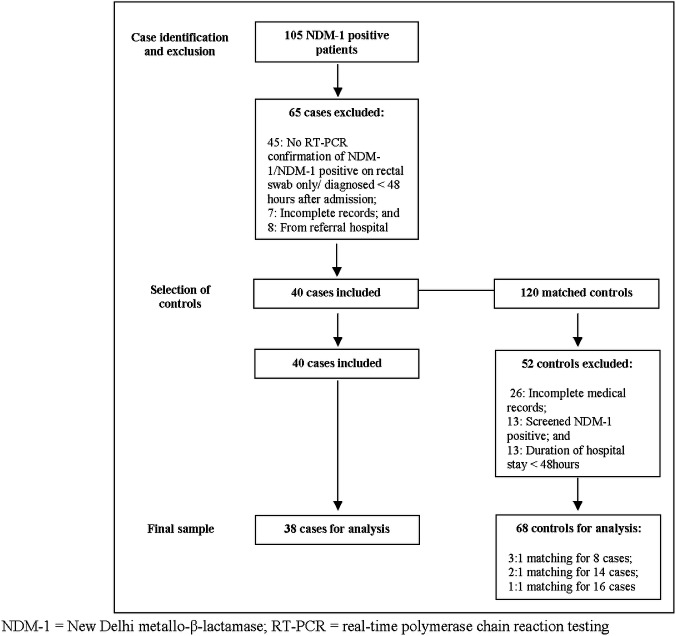
Study design and selection of cases and controls.NDM-1 = New Delhi metallo-β-lactamase; RT-PCR = real-time polymerase chain reaction testing.